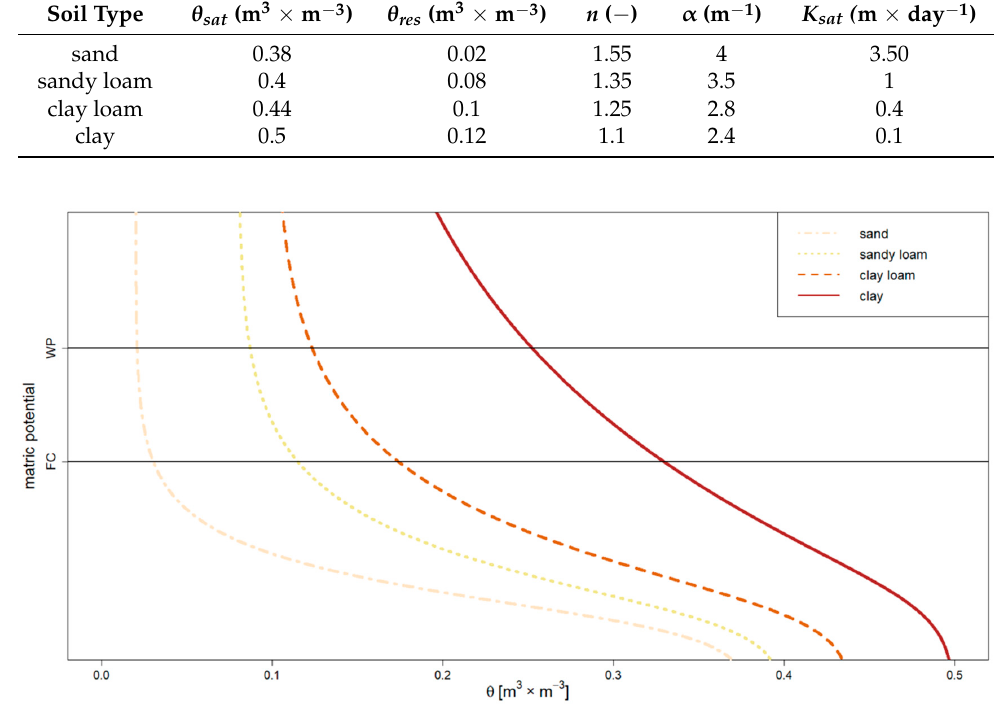
Figure A1. The figure displays the water retention curves of each pre ‐ set soil of 3PG ‐ Hydro.